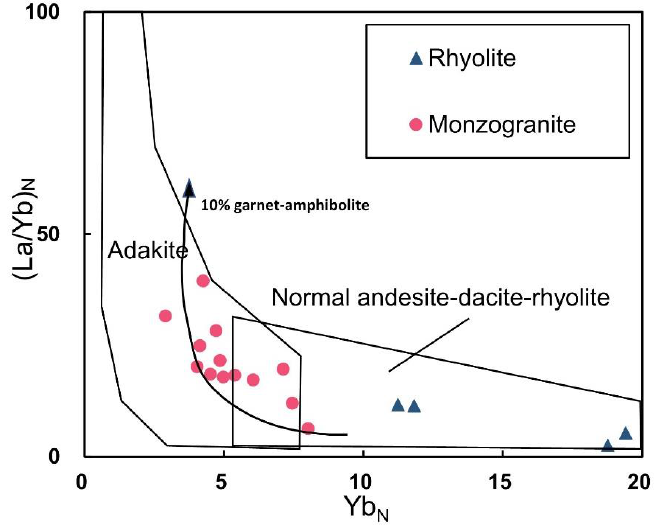
Figure 10. (La/Yb) N versus Yb N classification diagram for the Demingding monzogranite and rhyolite, after [45].